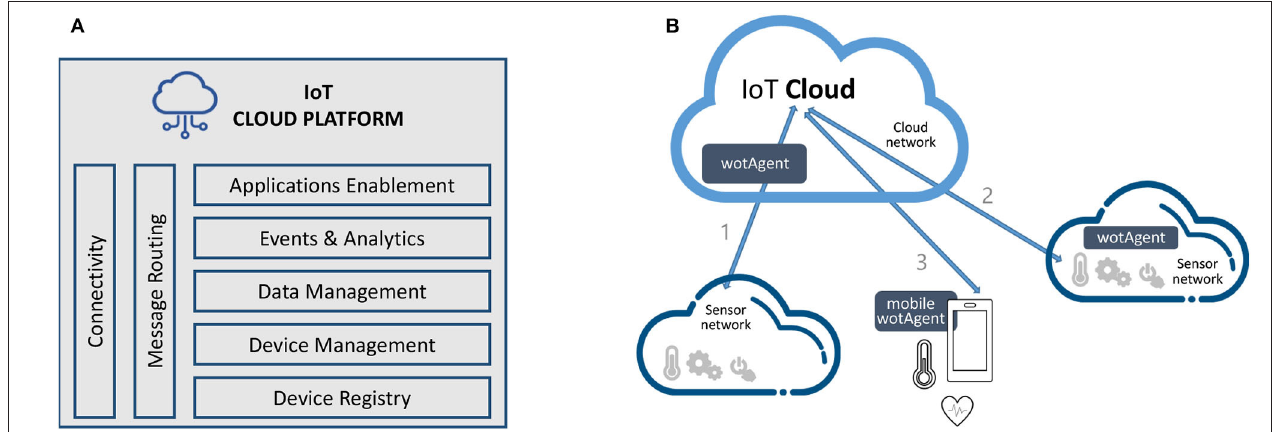
FIGURE 4 | The NESTORE IoT architecture: (A) server-side components and (B) the Web of Things model.